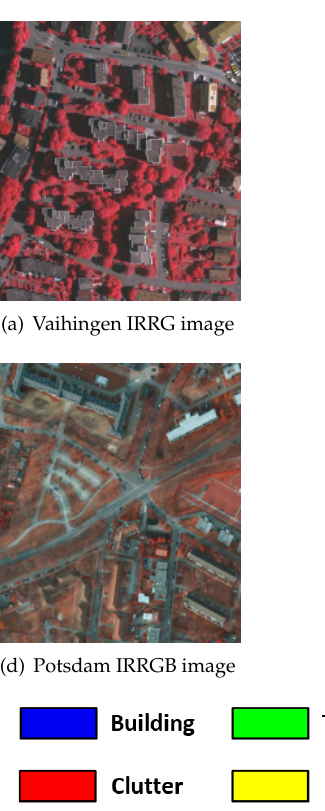
Figure 5. Some samples of ISPRS Vaihingen and Potsdam